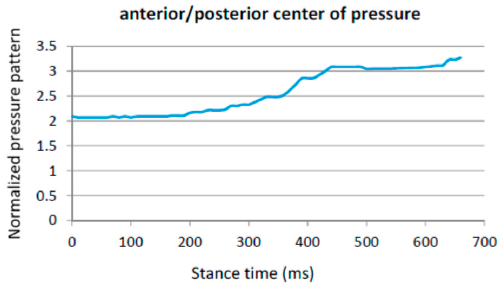
Figure 7. Anterior posterior centre of pressure over time (in milliseconds).